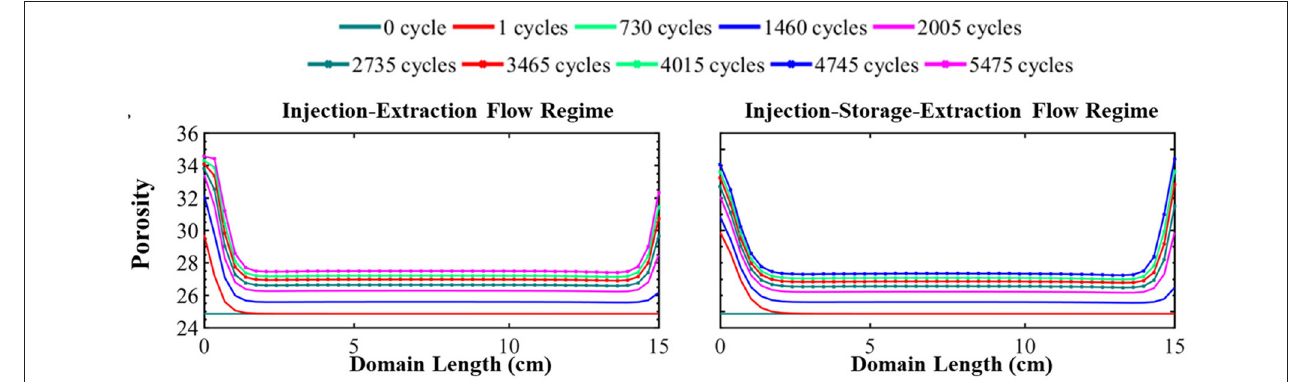
FIGURE 4 | The simulated evolution of porosity across the simulation domain over 15 years for the injection–extraction flow regime (left) and injection–storage–extraction flow regime (right). 0 years (dark green) is the initial condition and 15 years (dotted magenta) is the final condition. Red is 1 day, light green 2 years, blue 4 years, magenta 5.5 years, dotted dark green 7.5 years, dotted red 9.5 years, dotted light green 11 years, dotted blue 13 years, and dotted magenta 15